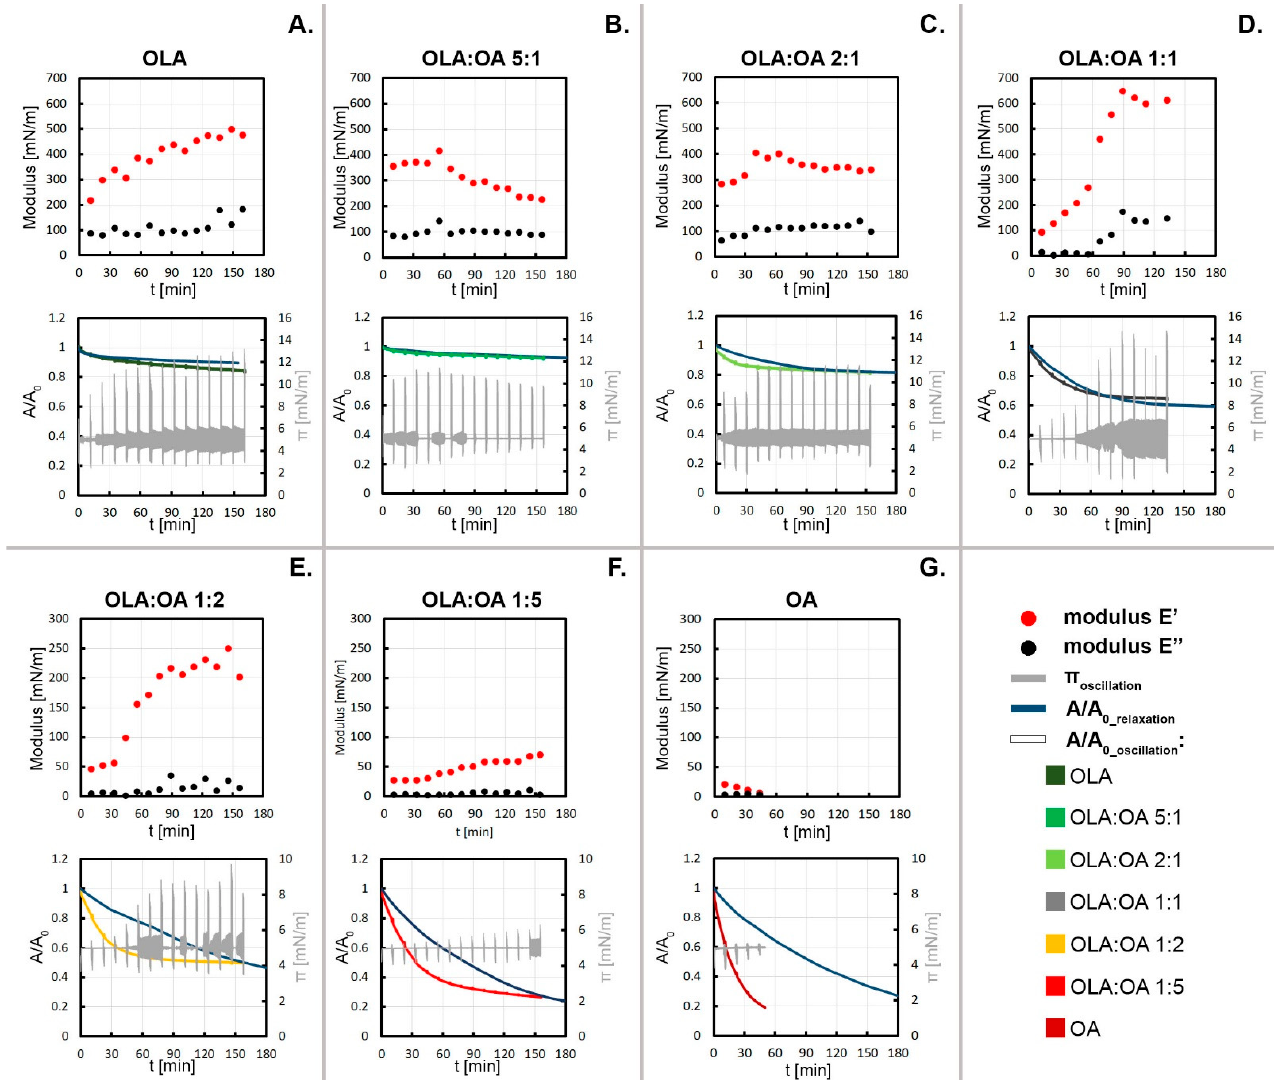
Figure 5. Viscoelastic moduli E’ and E” of the pure systems ( A , G ) and binary monolayers of OLA and OA ( B – F ) plotted vs. time and complemented by the graphs of the relaxation during oscillation experiments and without disturbances separately, as well as surface pressure vs. time, varying significantly due to the oscillation. Such a comprehensive set of results allows for a holistic assessment of system behavior at the interface due to the application of an oscillating force to the monolayers.